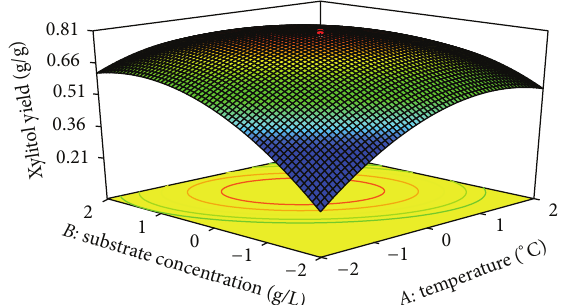
Figure 6: 3D plot showing the effect of temperature and agitation speed on xylitol